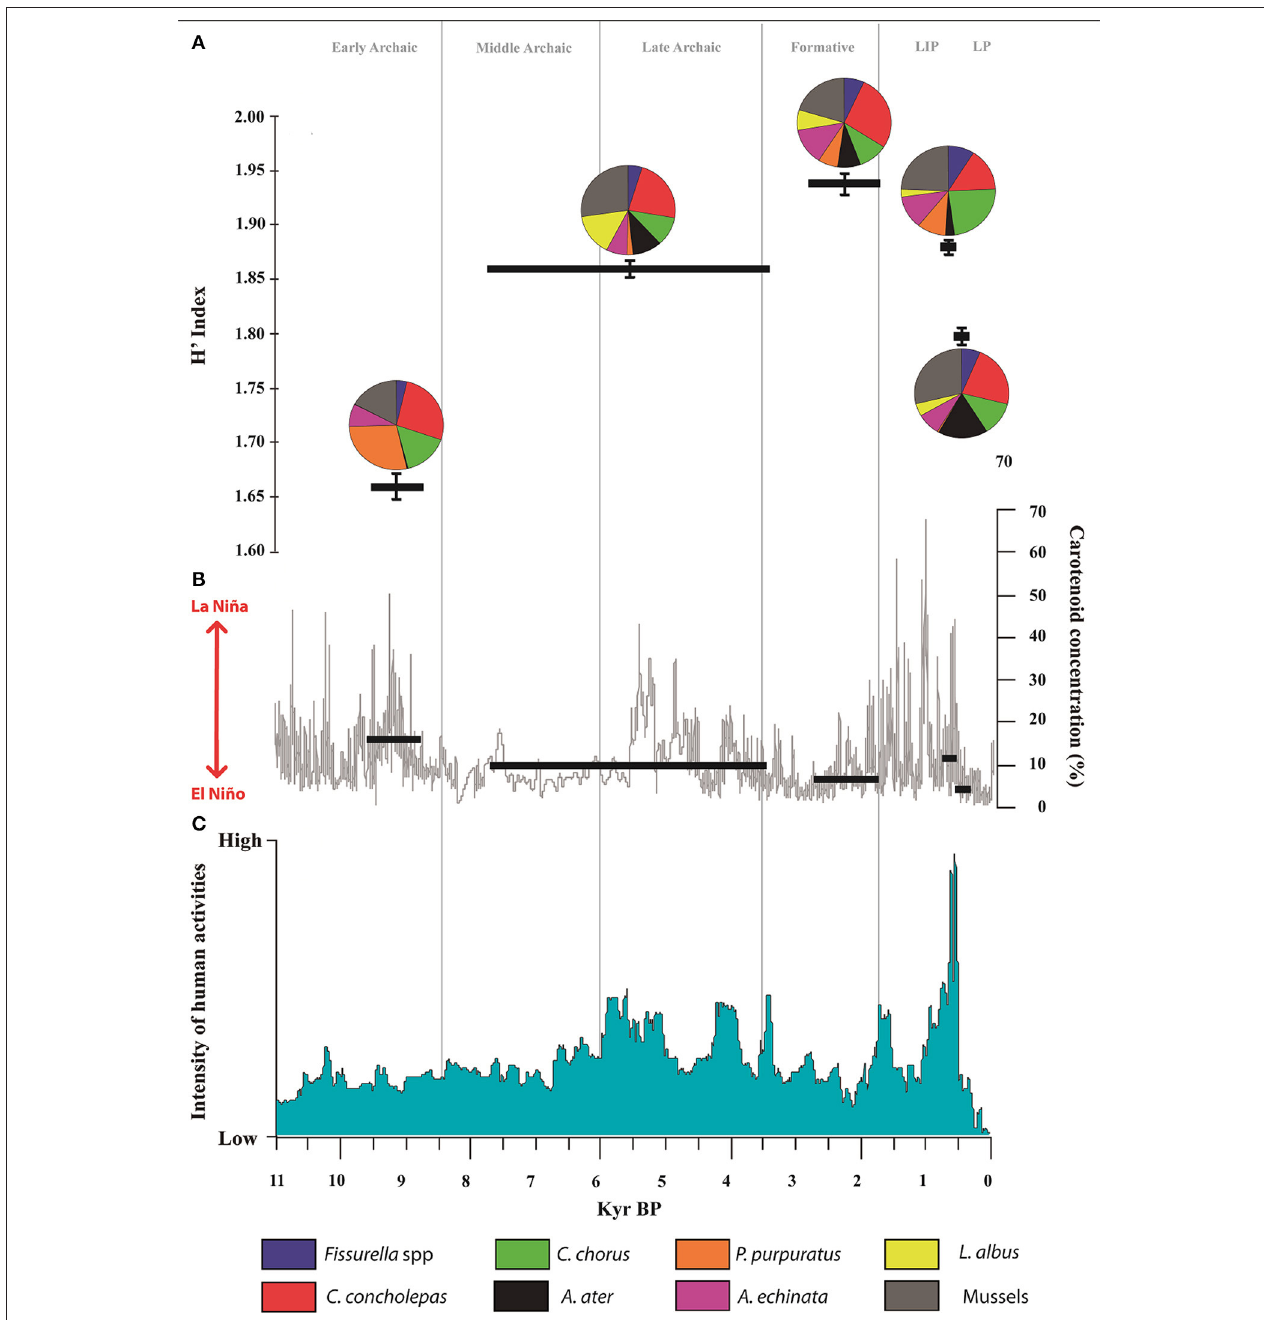
′ FIGURE 5 | (A) H Diversity index and pie charts for biomass relative abundances expressed as percentages for each shellfish assemblage. Fissurella spp. proportion: blue, Concholepas concholepas proportion: red, Choromytilus chorus proportion: light green, Aulacomya ater proportion: dark, Perumytilus purpuratus proportion: cyan, Acanthopleura echinata proportion: magenta, Loxechinus albus proportion: yellow, Mussels proportion: olive. (B) ENSO-driven changes in bioproductivity. Magenta and gray curves show raw (gray) and 50-year running mean (magenta) for carotenoid concentrations within the SO147-106KL marine core (Rein et al., 2005). Horizontal green bars show mean values for photosynthetic pigments throughout the constrained chronology of each cultural period. (C) Reconstructed intensity of human activity in the coastal Atacama Desert over the past 10,000 years (after Gayo et al., 2015). Vertical light gray lines represent the real duration of cultural periods. Major regional-scale wet (light blue) and dry (orange bars) phases are provided at the top of the figure.